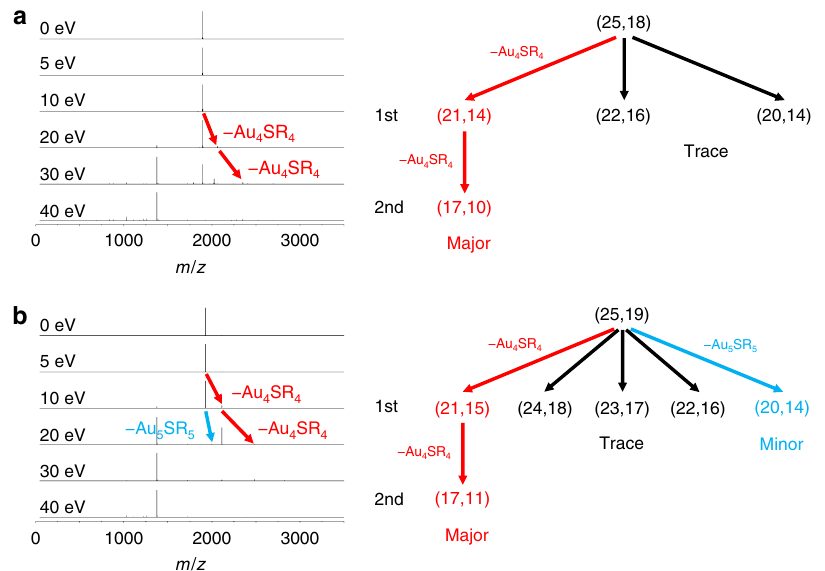
Fig. 5 Tandem mass testing of the Au 25 species. Tandem mass spectra and corresponding fragmentation patterns of ( a ) [Au 25 MHA 18 ] and ( b ) [Au 25 MHA 19 ] 0 . ( m , n ) denotes species with molecular formula of Au m SR n . Different routes are divided into major, minor, and trace categories based on the abundance in tandem mass spectra. See Supplementary Fig. 7 and 8 for detailed assignments of fragment species.